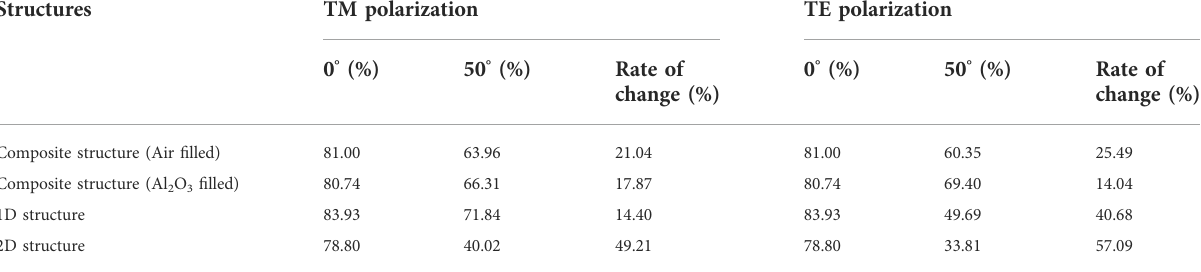
TABLE 4 Spectral ef fi ciency andrate ofchange ofspectral ef fi ciency of composite structure (Air fi lled andAl 2 O 3 fi lled), 1D structure and 2D structure for incident wave TM and TE polarization with incidence angle θ = 0 ° and θ = 50 ° .